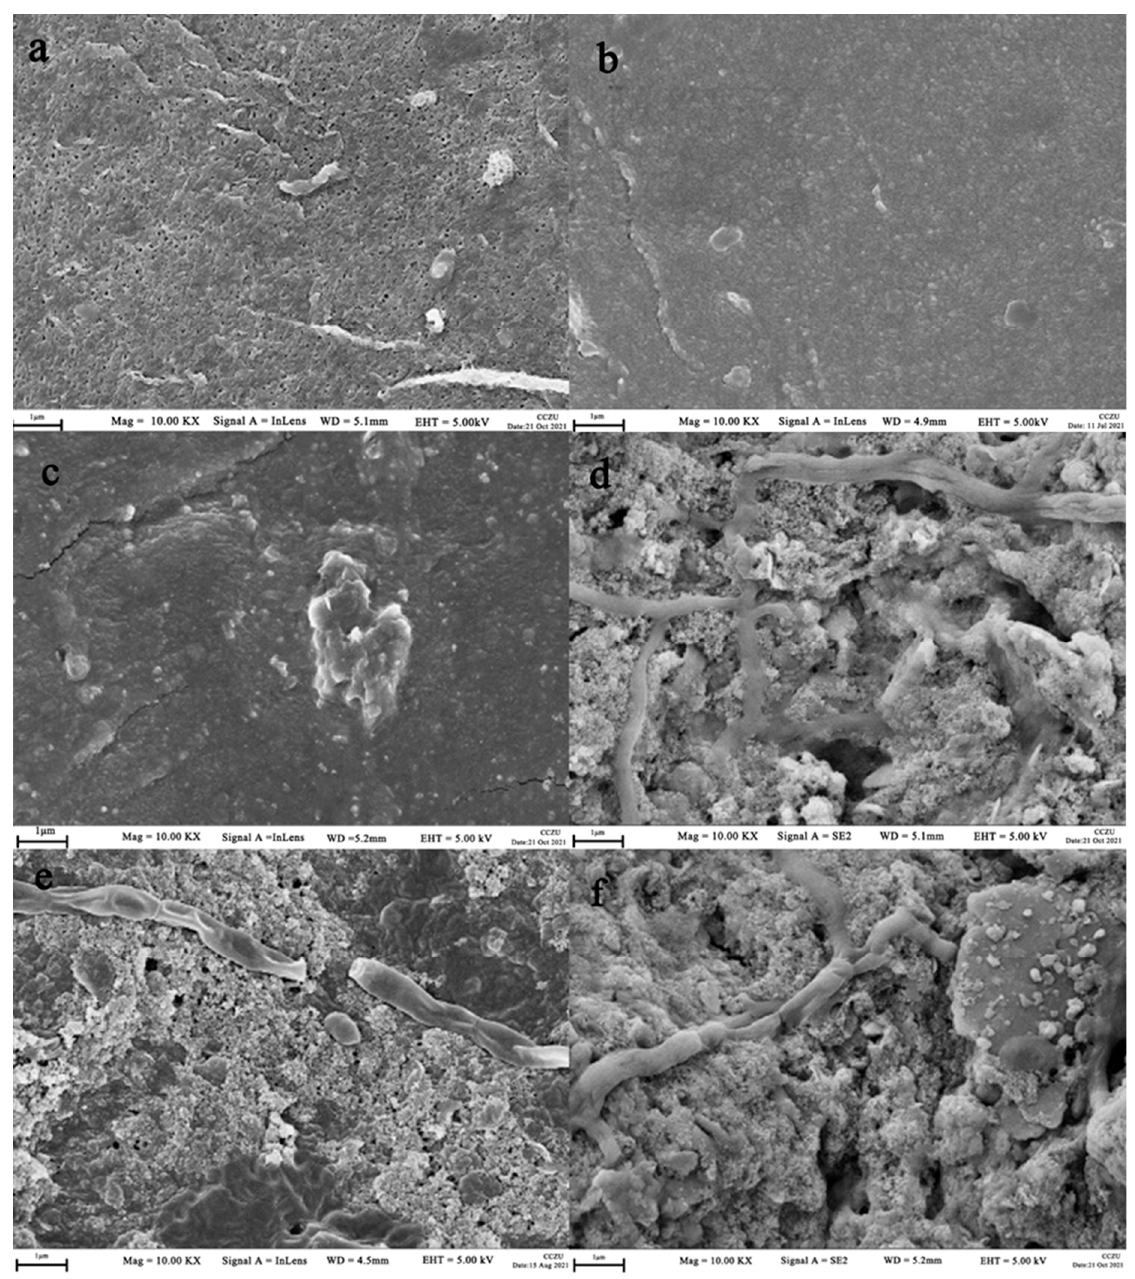
Figure 5. The SEM images of membrane: ( a ) the new membrane; ( d ) the newly contaminated membrane; ( b ) chemically cleaned membrane; ( e ) membrane fouled again after cleaning; ( c ) membrane cleaned for the second time; and ( f ) membrane fouled for the third time.